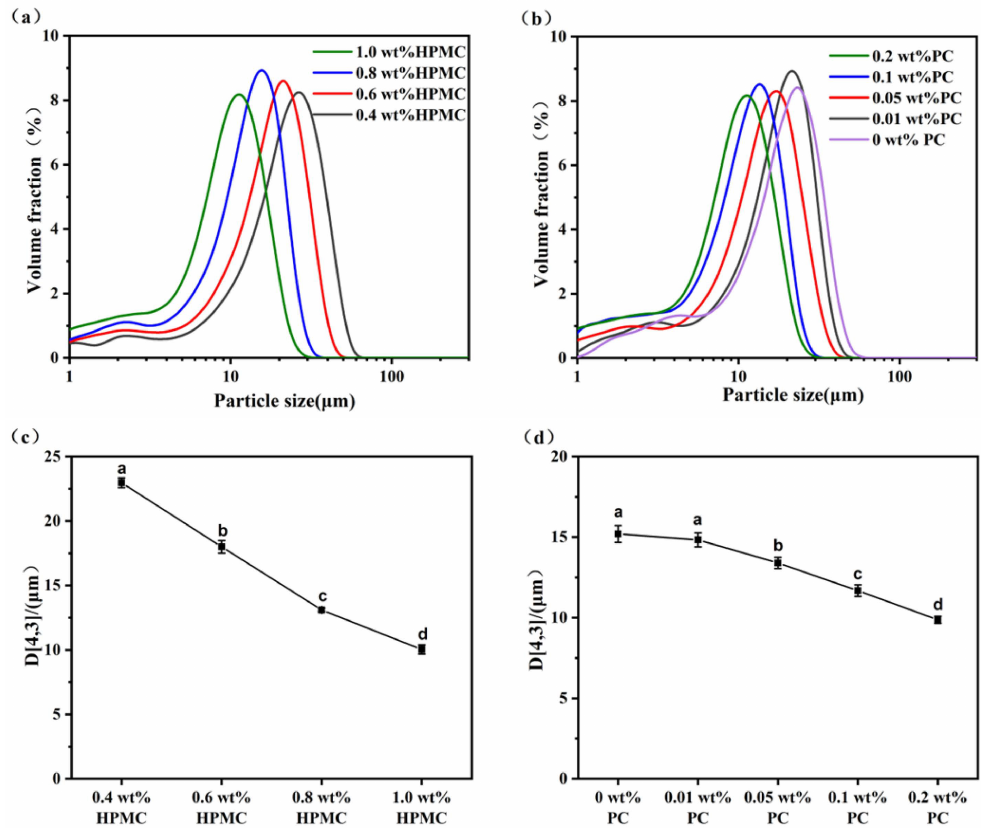
Figure 2. Droplet size distribution curves ( a ) and volume-average diameters (D[4,3]) ( c ) of different concentrations of HPMC emulsions, when the PC concentration was constant at 0.1 wt%. Droplet size distribution curves ( b ) and volume-average diameters (D[4,3]) ( d ) of different concentrations of PC emulsions, when the HPMC concentration was constant at 0.8wt%. Letters a–d indicate significant difference in different emulsions ( p < 0.05). (HPMC—Hydroxypropyl methylcellulose,